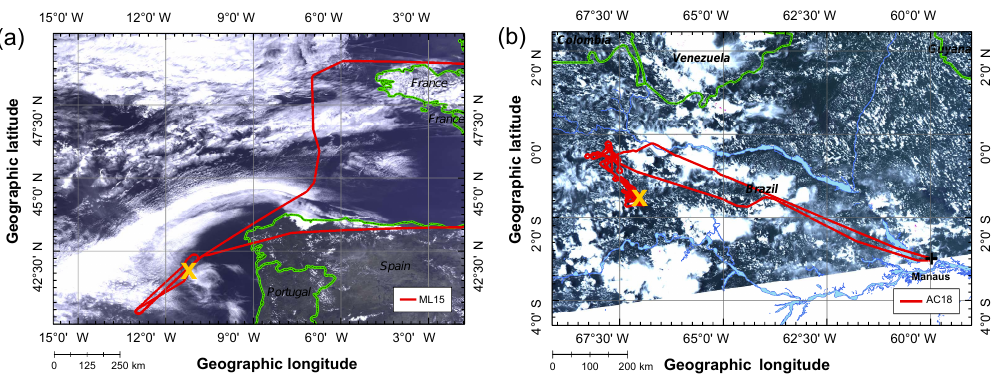
Figure 1. (a) The red line is the HALO flight path of ML-15 on 13 April 2014, while (b) is for AC-18 on 28 September 2014 overlaid with corresponding MODIS true color image. The yellow cross indicates the flight section that is selected for the